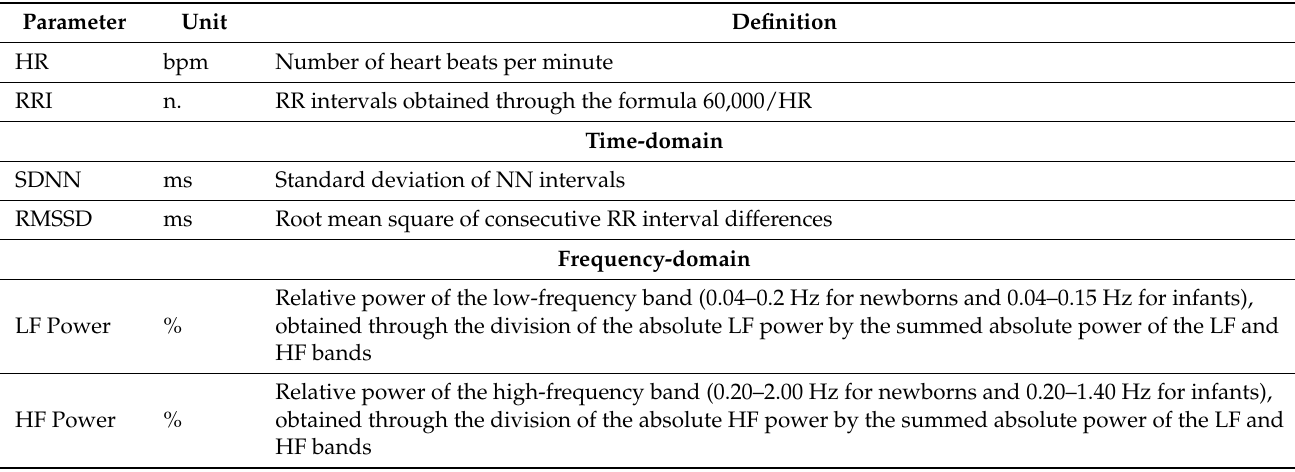
Table 1. Extracted HRV metrics